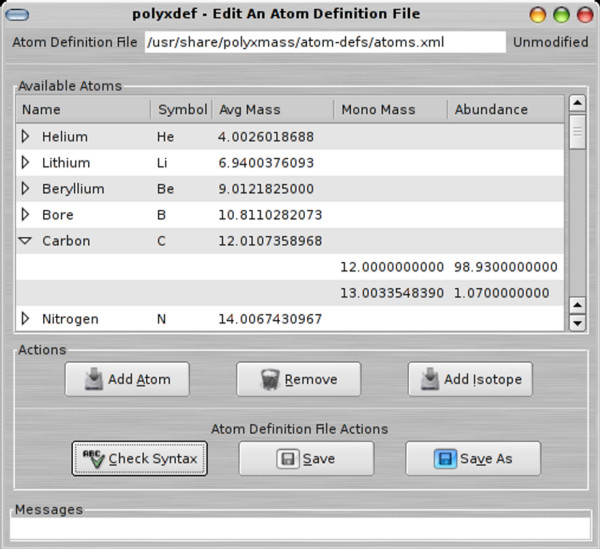
Atom definitions in the polyxdef module. The definition of atoms is straightforward: after creation of a new atom "envelope", the user fills-in the isotopic pairs (isotopic mass and relative abundance) required to fully characterize a chemical element. Each time a new isotope is added, the average mass of the chemical element gets recomputed.